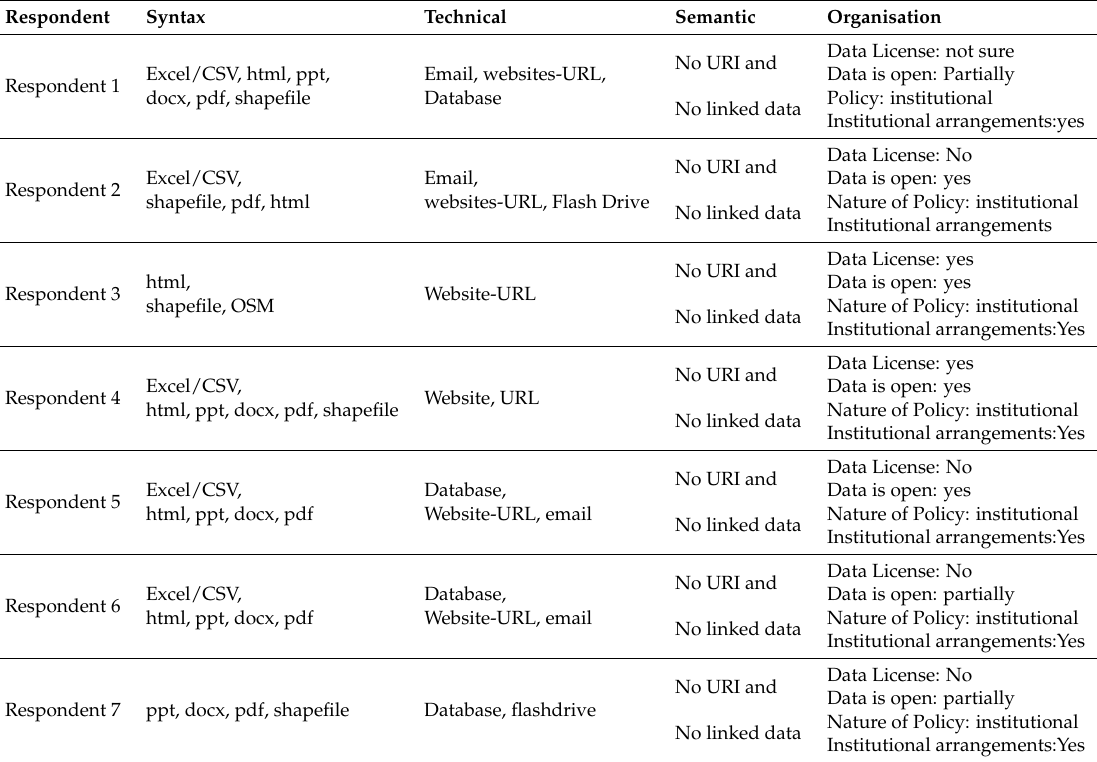
Table A2. Qualitative measurement of disaster data interoperability.